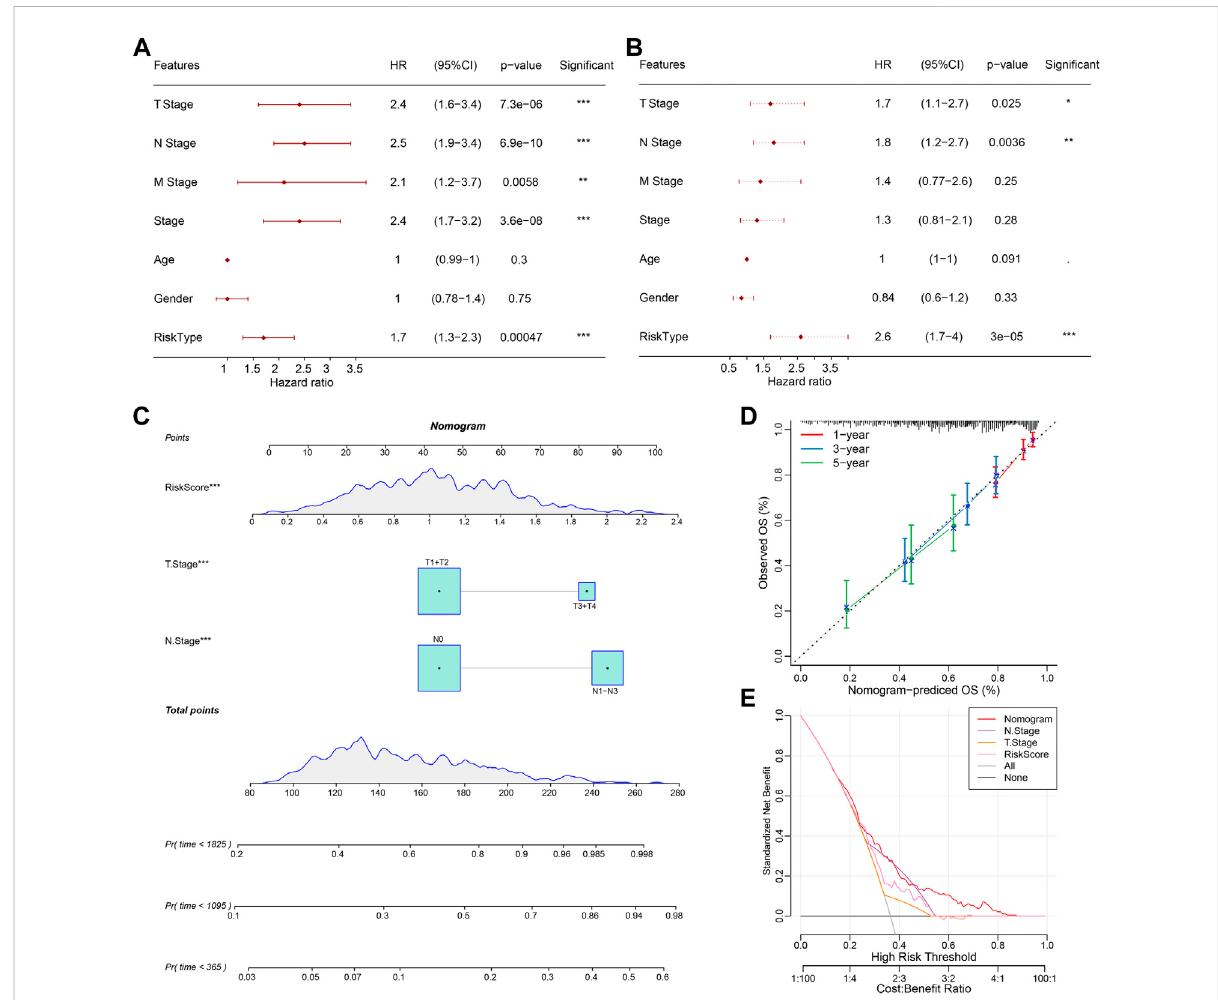
FIGURE 8 Validation of the predictive accuracy and reliability of the RiskScore prognostic model. (A, B) Univariate and multifactorial Cox analyses of RiskScore and clinicopathological features; (C) Nomogram model; (D) Calibration curves for 1, 3, and 5 years for the nomogram; (E) Decision curve (DCA) for the nomogram. * p < 0.05, ** p < 0.01, *** p <